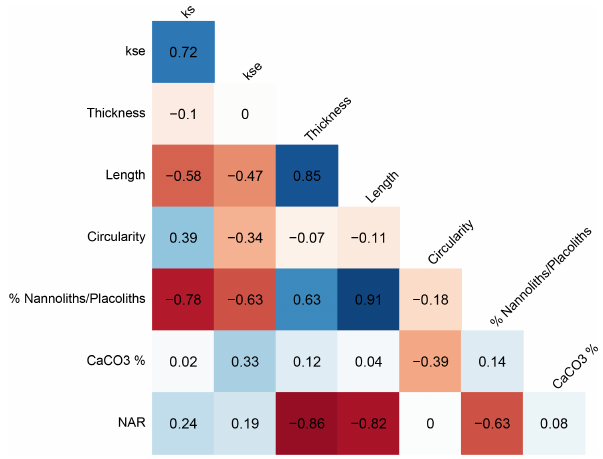
Figure 6. Cross correlation of temporal changes in median geomet- rical indicators for the 11 studied intervals.